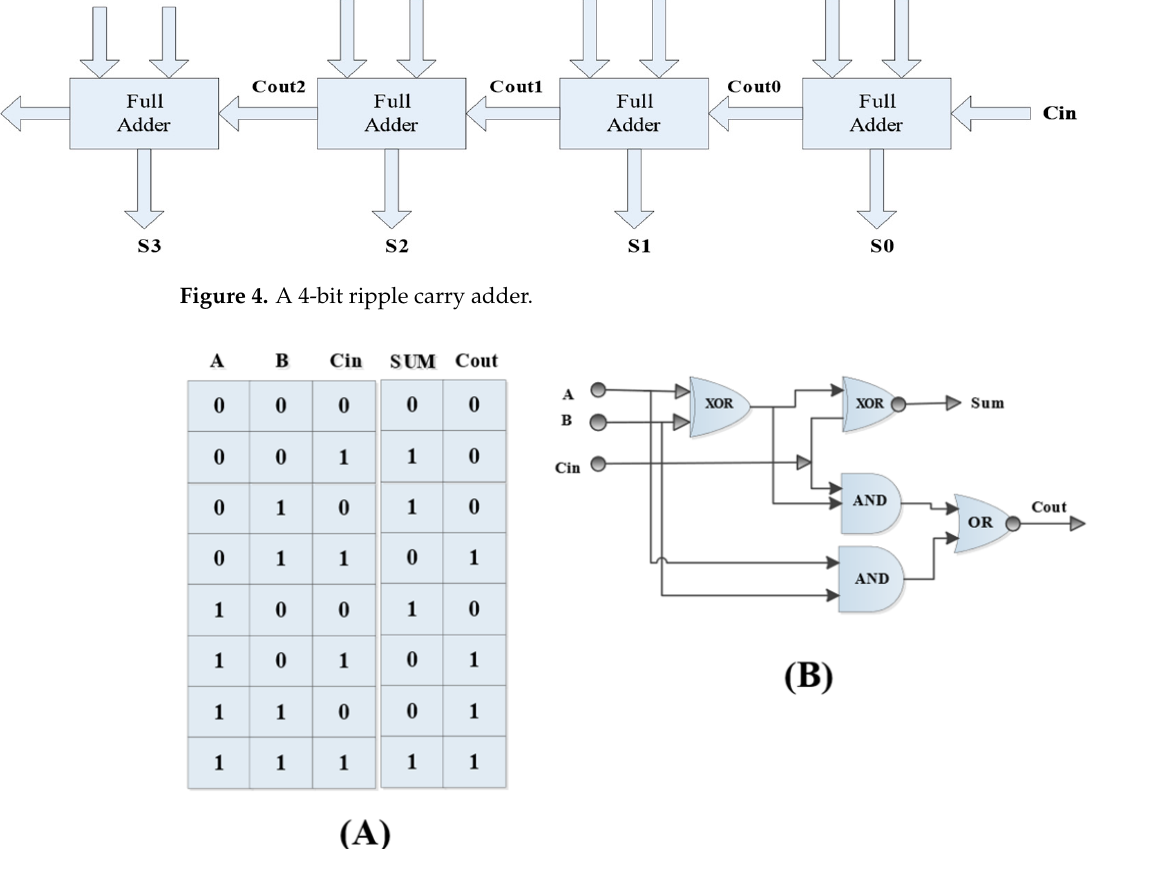
Figure 5. 4-bit full adder: ( A ) truth table and ( B ) logic gate.